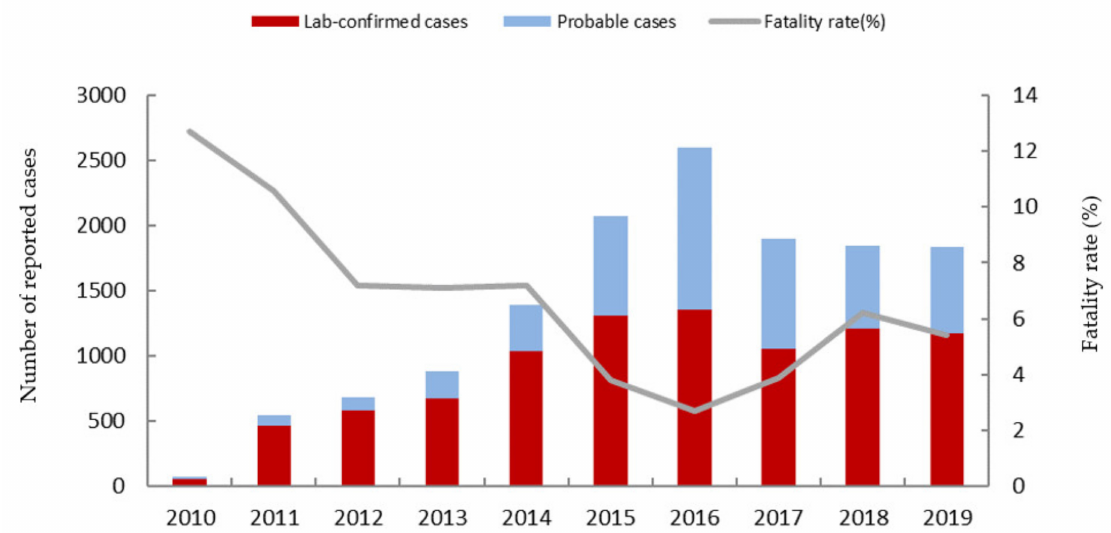
Figure 1. The number of severe fever with thrombocytopenia syndrome (SFTS) cases and the fatality rate from 2010 to